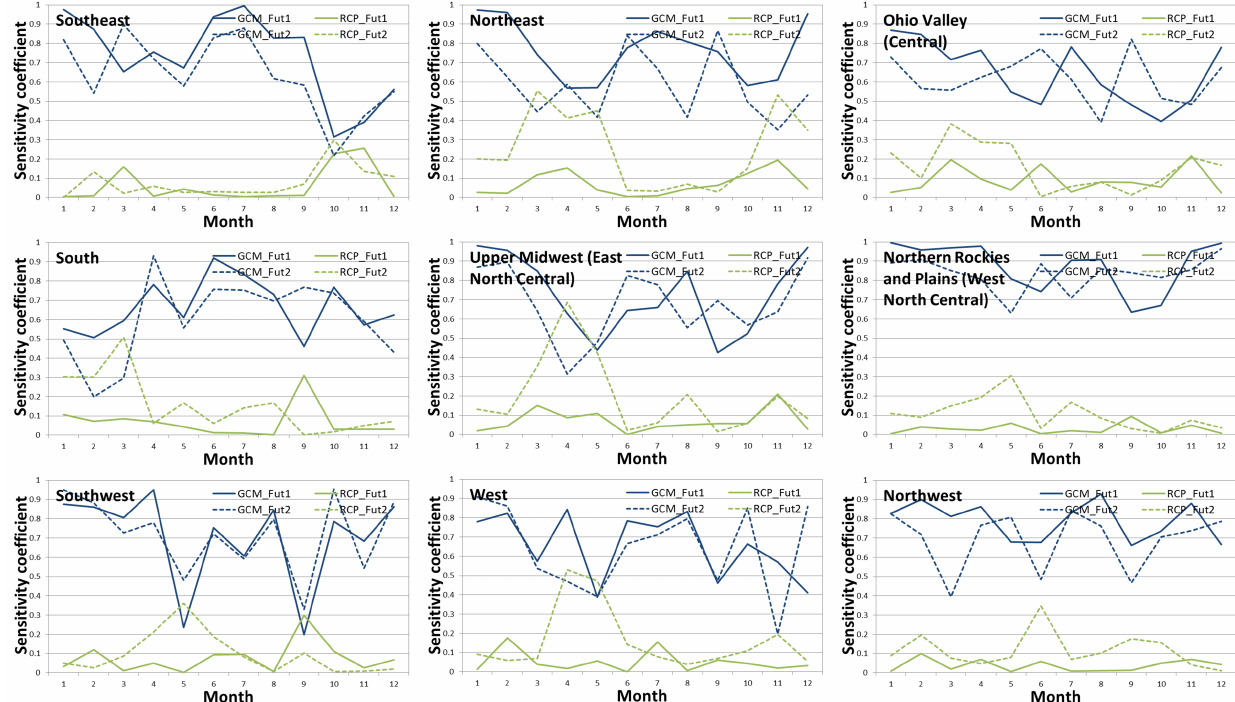
Figure 5. First-order sensitivity analysis results of change in precipitation. Solid lines represent future period 1 (2030–2060) and dotted lines represent future period 2 (2070–2100). Blue lines represent the first-order effect of GCMs and green lines represent the first-order effect of